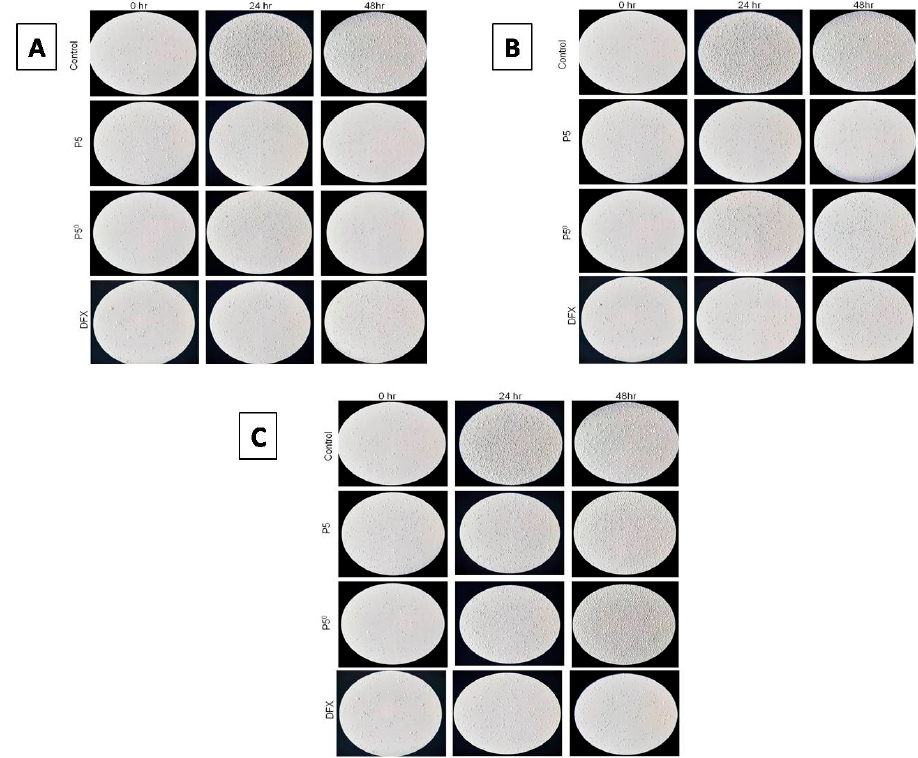
Figure 7. Light microscope images of K562 cells which were exposed to P5-40, P5 0 , and pure DFX of concentrations ( A ) 40 μ M, ( B ) 30 μ M, and ( C ) 10 μ M for 24 and 48 h and control for comparison.